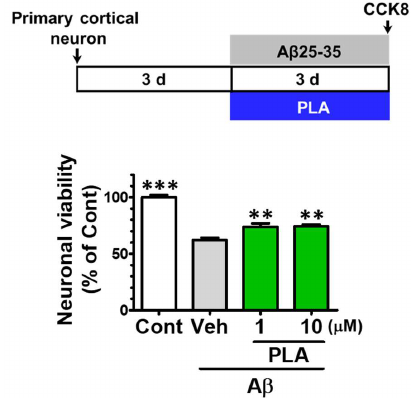
Figure 6. Effects of platycodigenin (PLA) on Aβ25-35-induced neuronal death. Primary cultured cortical neurons were cultured for 3 d and treated with PLA (1 and 10 μM) and/or Aβ25-35 (10 μM) for another 3 d. The neuronal viability was determined by CCK8 analysis. The data are normalized to the control and shown as the mean ± SEM of three independent experiments. Each group has five replicates in the independent experiment. ** p < 0.01 and *** p < 0.001 versus vehicle (Veh), Kruskal-Wallis one-way analysis of variance by ranks test.